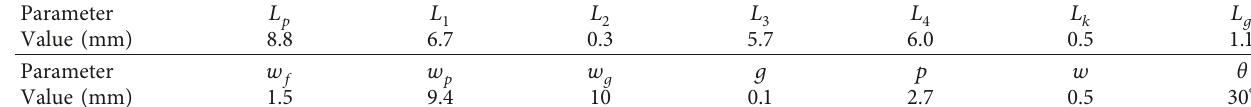
Table 1: Bio-inspired MTM backed antenna optimized design